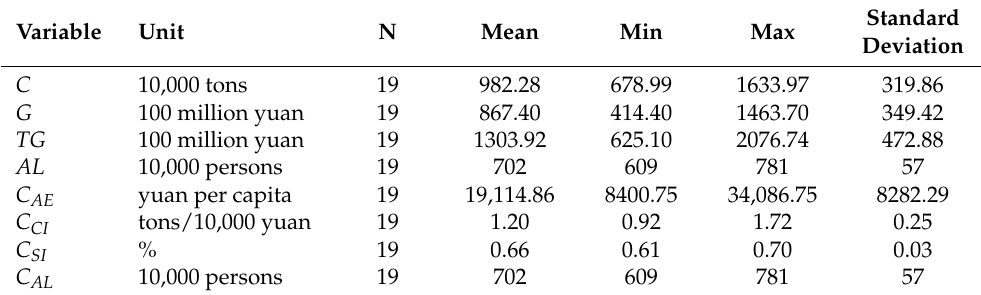
Table 3. Descriptive statistical analysis of